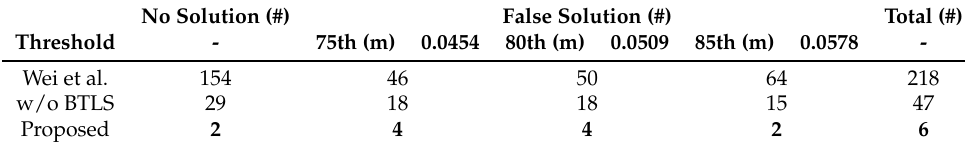
Table 4. Number of false and no solutions for real data.